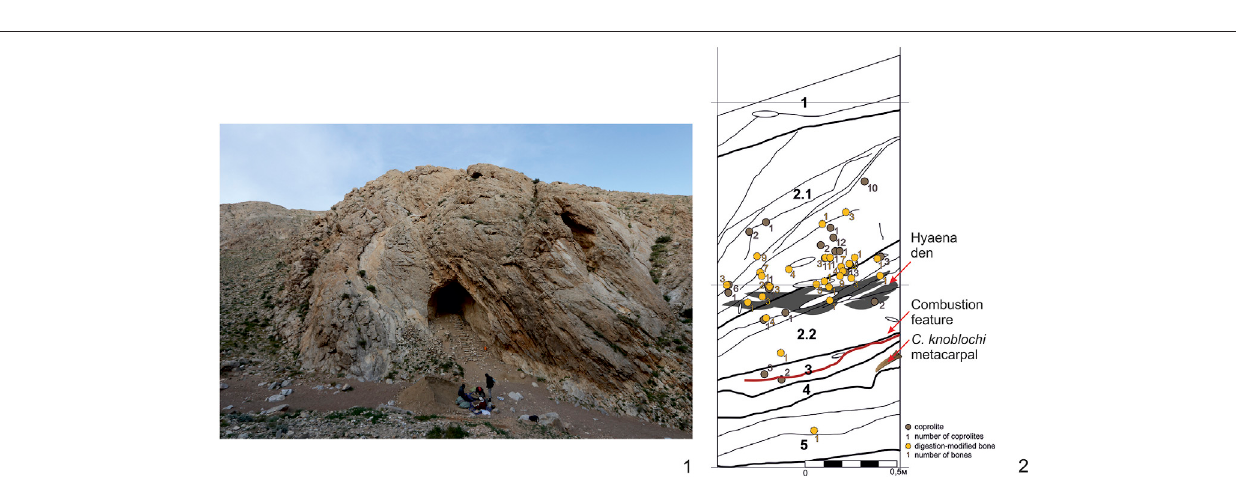
Frontiers in Earth Science |